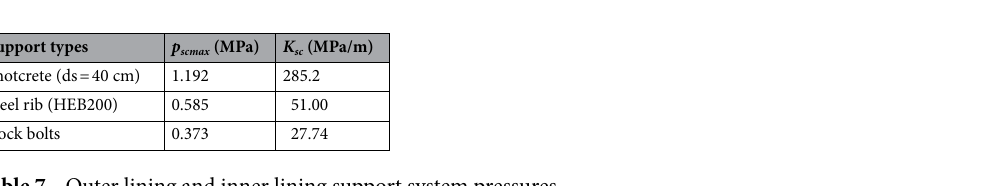
Table 7. Outer lining and inner lining support system pressures.